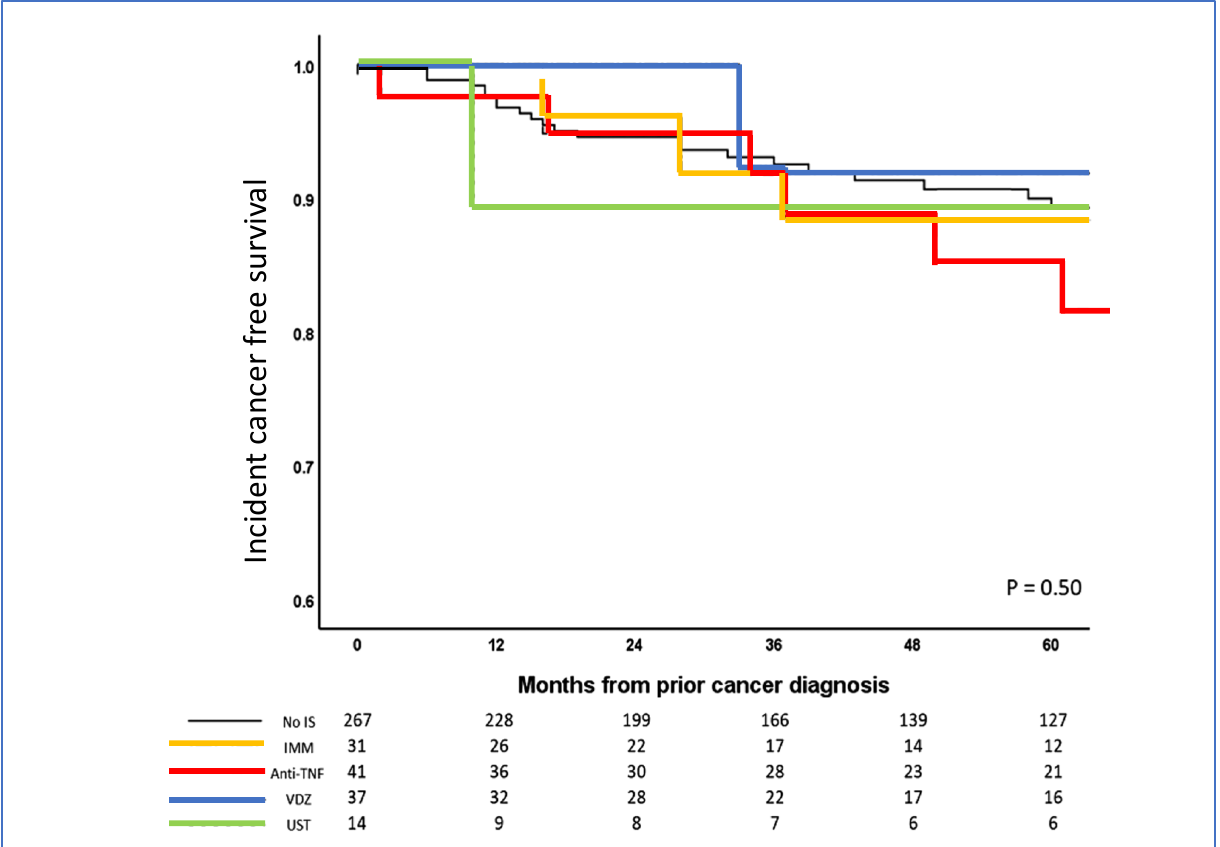
Figure 4. Incident-cancer-free survival with immunosuppressants, anti-TNFs, vedolizumab, and ustekinumab in IBD patients with previous malignancy